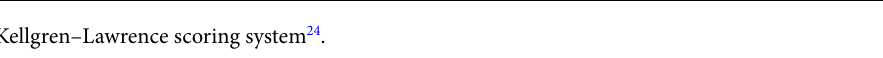
Table 1. Kellgren–Lawrence scoring system 24 .